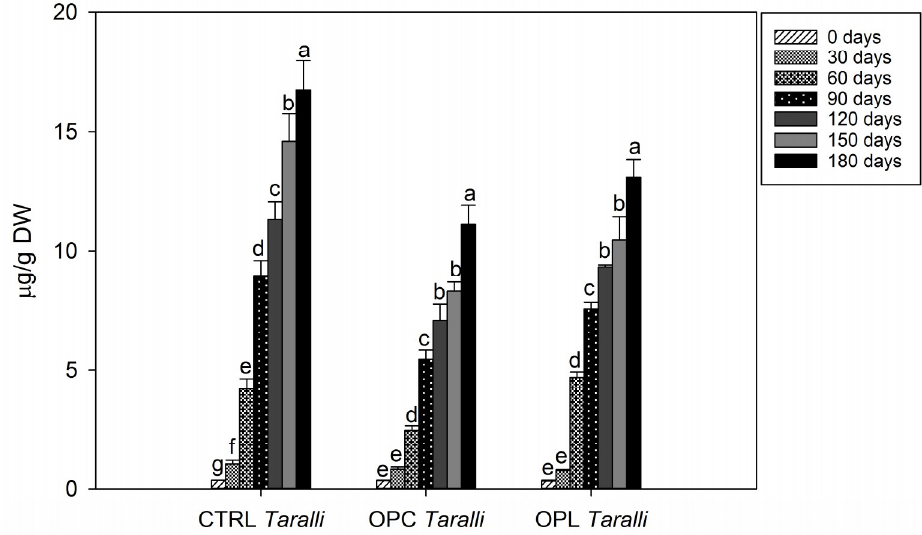
Figure 1. Time course of the amounts of hexanal during the storage of control (CTRL) and taralli enriched with fermented olive paste from Cellina di Nardò (OPC) or Leccino (OPL) olive cultivars at 25 °C, 500 lux, and in clear plastic bag for 180 days. Data are the mean ± standard deviation of three independent replicates ( n = 3). Data were submitted to one-way analysis of variance (ANOVA), Tukey’s test was applied to compare the experimental times (0, 30, 60, 90, 120, 150, 180 days) within the same sample. Different letters mean significant difference at p < 0.05.